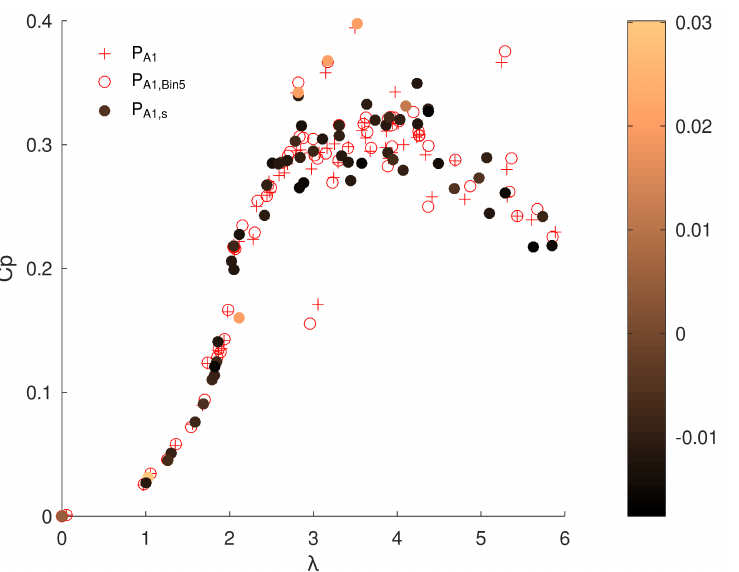
Figure 15. C p – λ data based on raw DA A1 data vs selected bin 5 vs steady 30 s section according to V1. Colour indicates vertical slope.